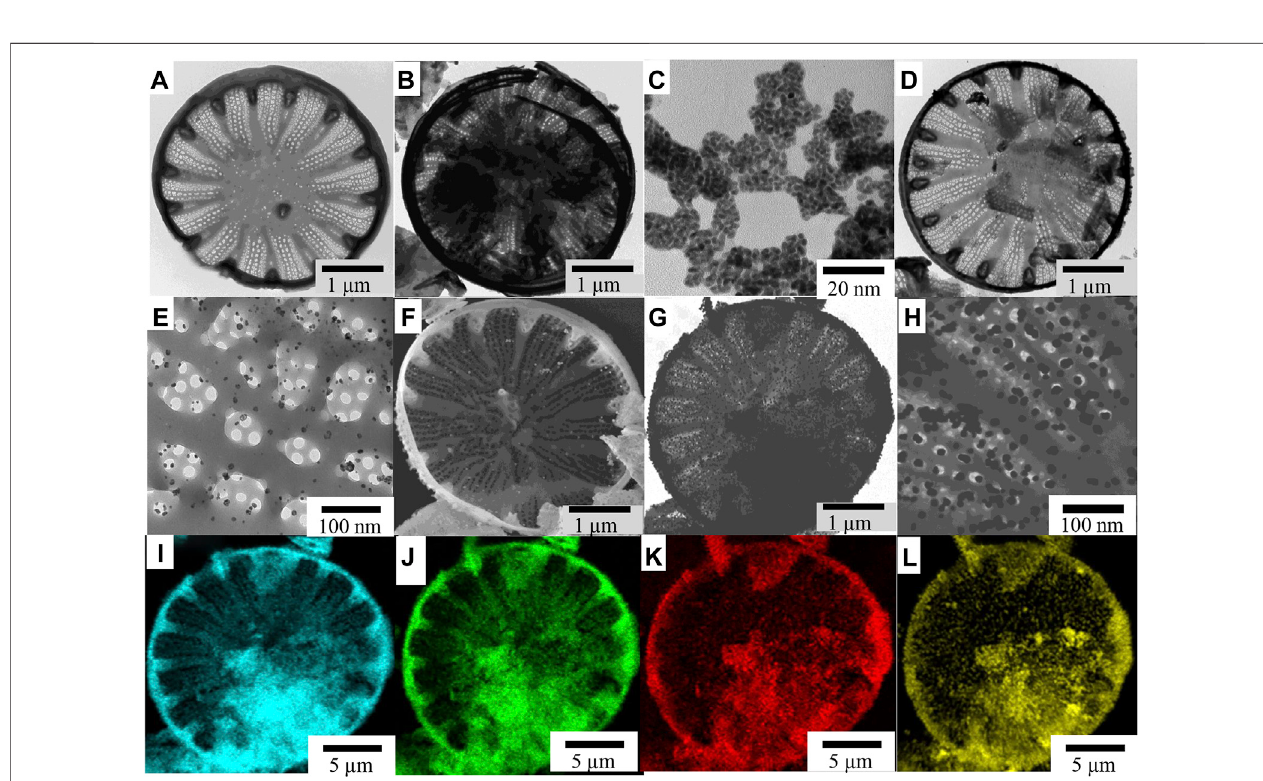
FIGURE 1 | TEM images of (A) frustule of C. cryptica, (B) PDA-coated diatoms, (C) free AuNPs, (D) 172 AuNP-deposited DBs-PDA, and (E) details of AuNPs on thesurfaceofDBs-PDA.SEMimagesof173 (F) DBs-PDA-AuNPs, (G) DBs-PDA-AuNPs,and (H) detailsofAuNPsontheDBs-PDA. (I – L) Intotal,174EDSimagesof (I) Si, (J) O, (K) C, and (m) Au in